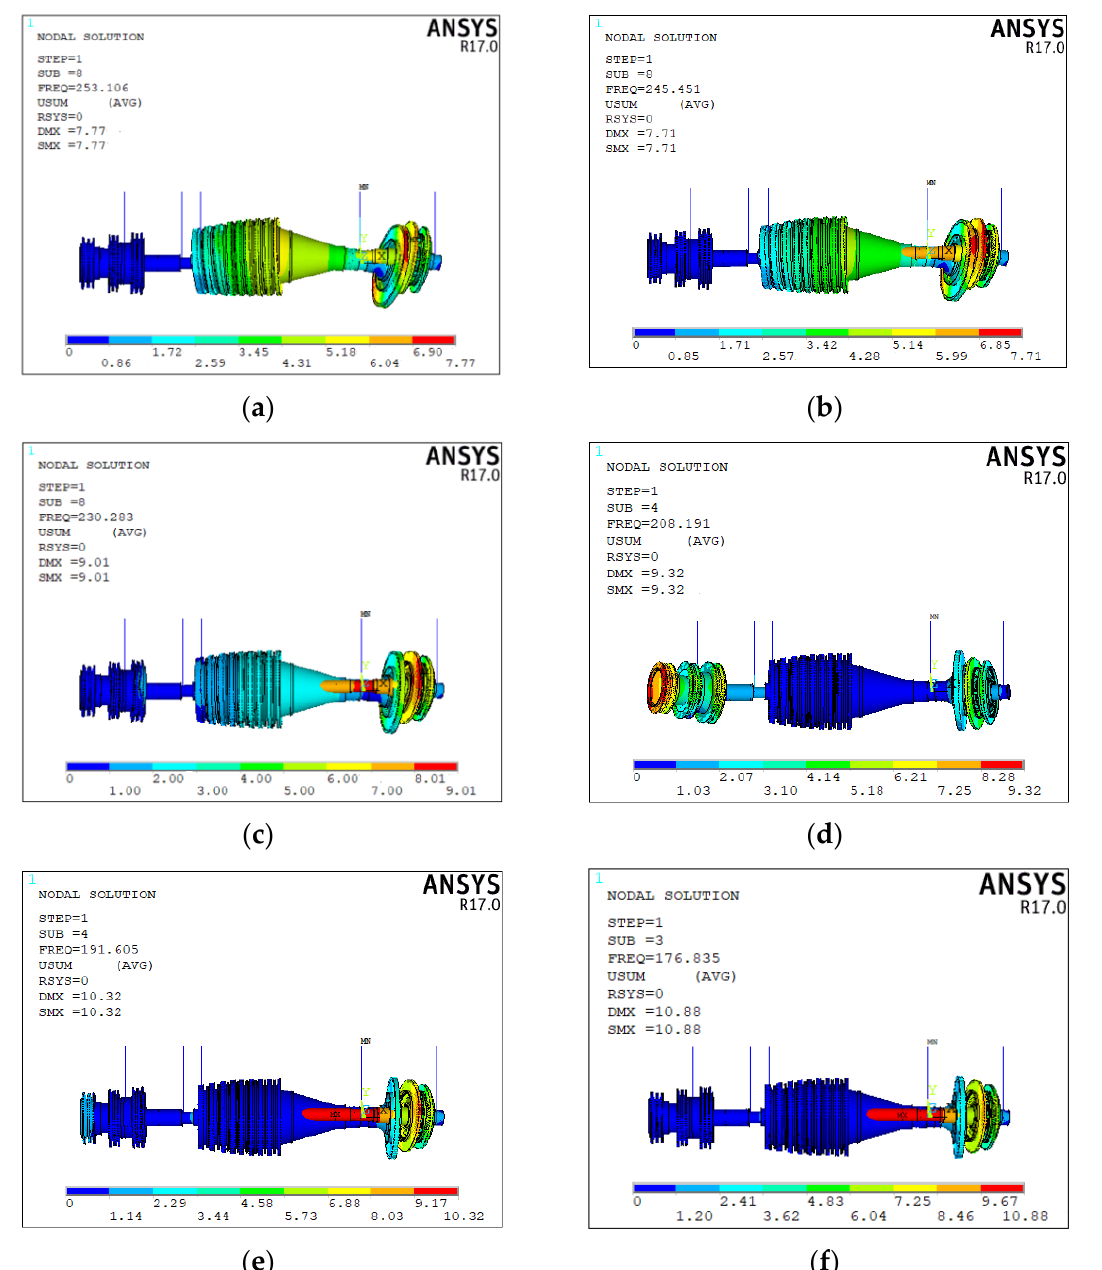
Figure 14. The 3rd order modals for contrast in different parallel non-concentricity: ( a ) δ = 0.5 mm; ( b ) δ = 1.0 mm; ( c ) δ = 1.5 mm; ( d ) δ = 2.0 mm ( e ) δ = 2.5 mm; ( f ) δ = 3.0 mm.